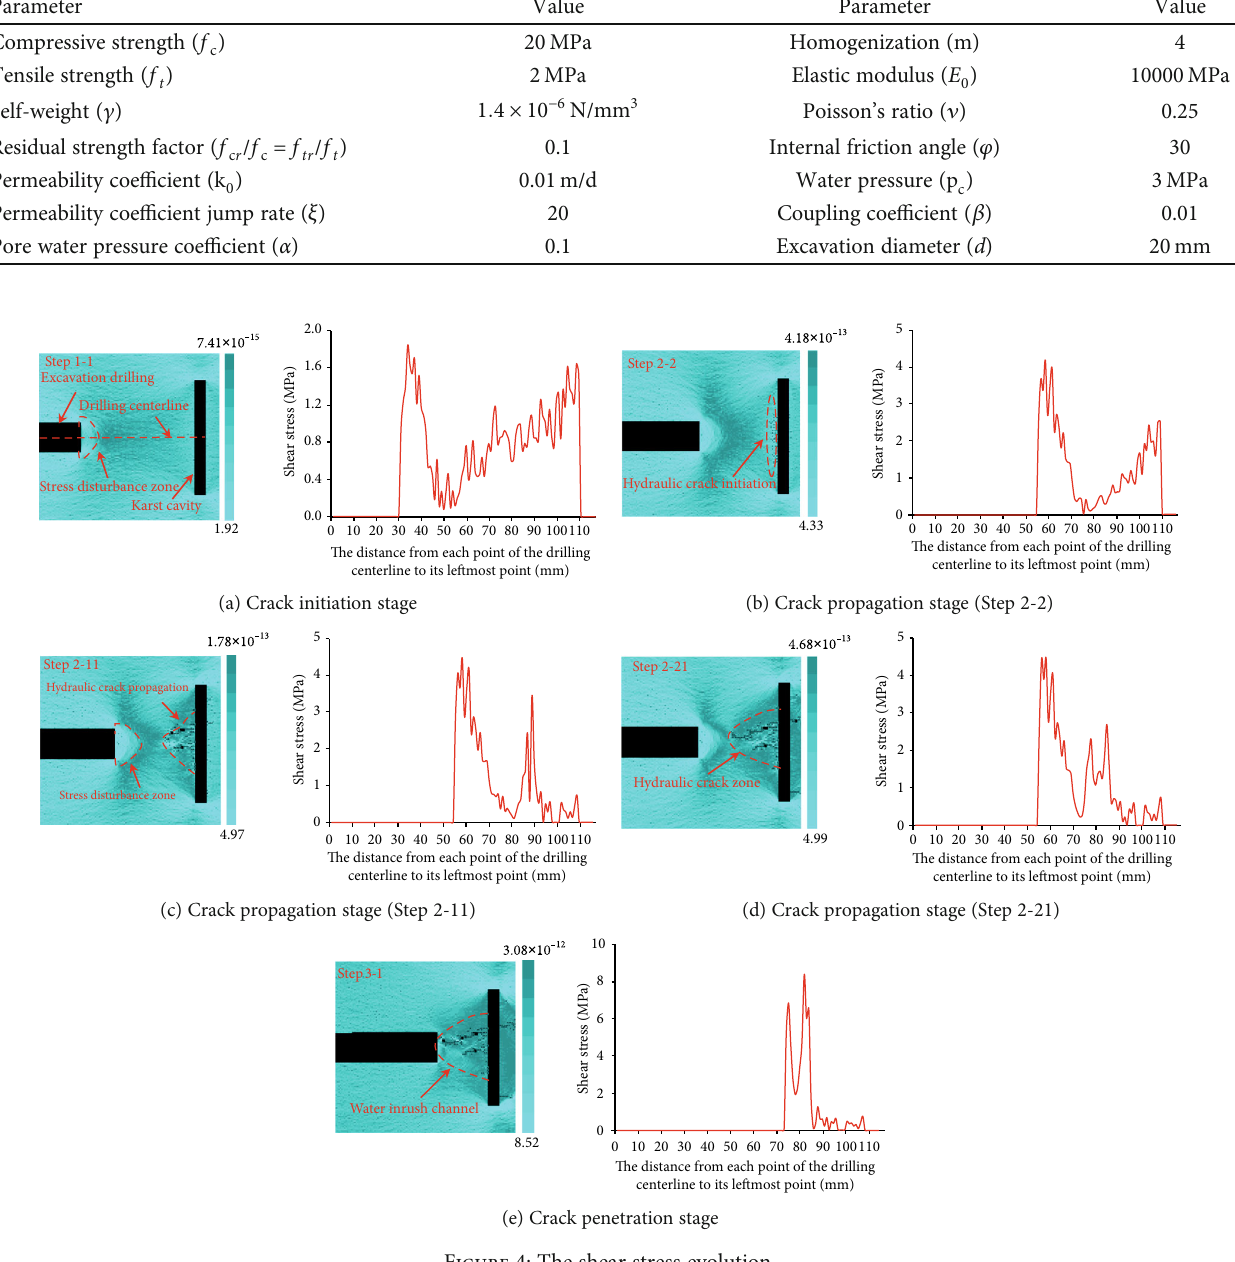
Figure 4: The shear stress